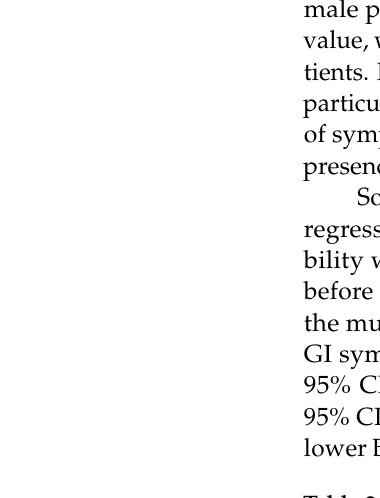
Table 2. Multivariate logistic regression. Variables associated with the female gender (dependent variable) at the time of CD